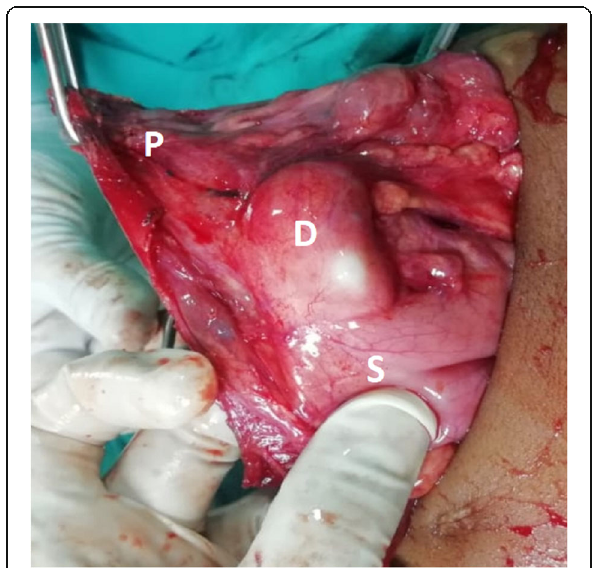
Fig. 3 Intraoperative photograph showing gastric duplication (D) intimately attached to the greater curvature of the stomach (S). The opened pseudocyst (P) is also